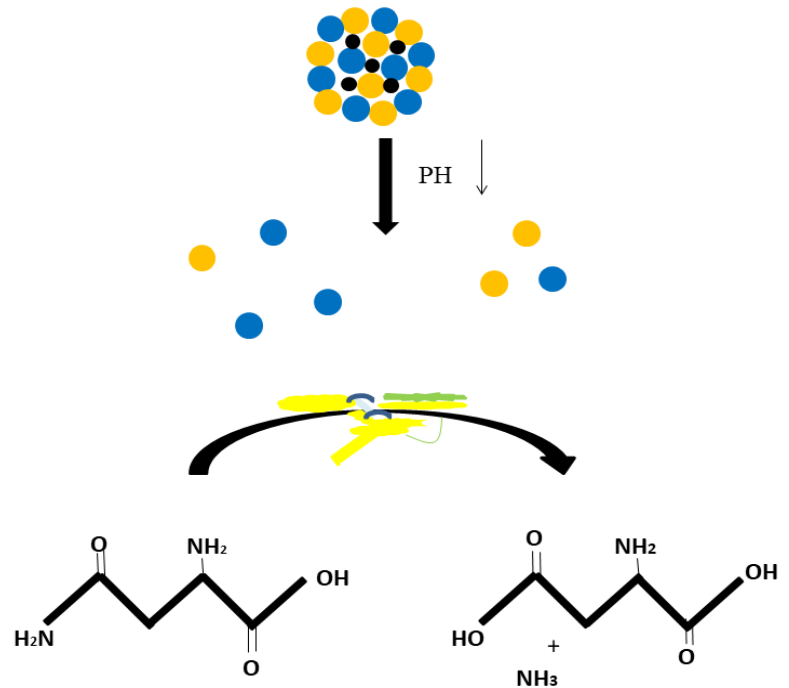
Figure 3. pH-responsive nanogels may be activated by an increase in pH caused by environmental change pH responsive nanogels.